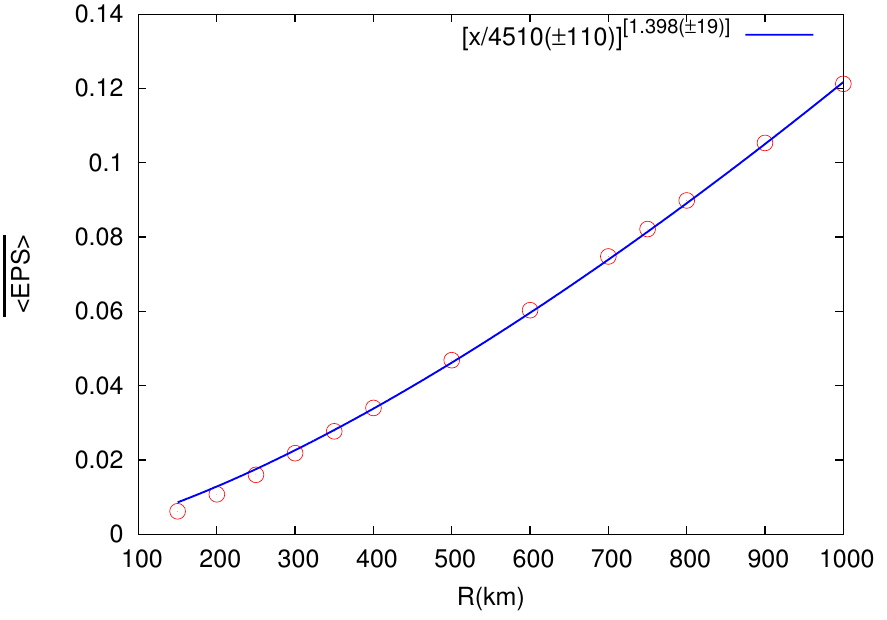
Figure 8. The mean value (cid:104) EPS (cid:105) (red circles) over all the grid points of the average EPS maps for the six M ≥ 8.5 EQs (see Table 2 and Figure 5) versus the coarse grain radius R . It exhibits a power law behavior and the corresponding power law fit is shown in